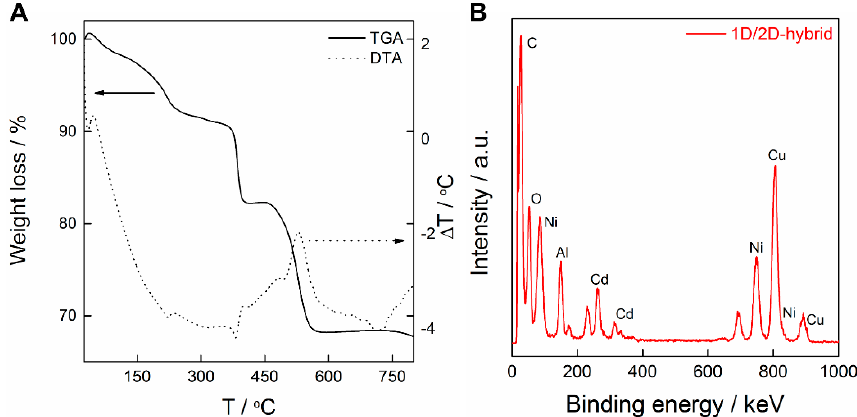
Figure 1. Termogravimetric (TGA/DTA) analysis ( A ) and electron probe microanalysis ( B ) of the 1D/2D hybrid .